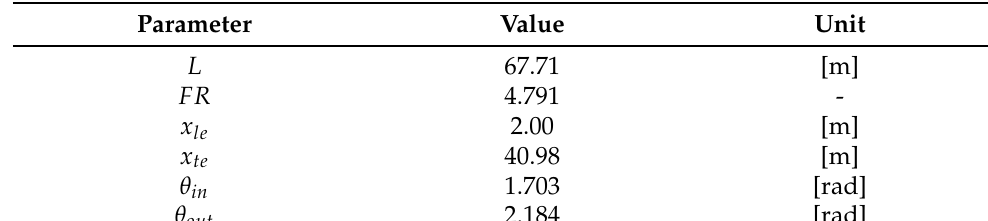
Table 10. Design variables defining the optimal sizing for operation at 18.06 km altitude above Port-au-Prince, Haiti.